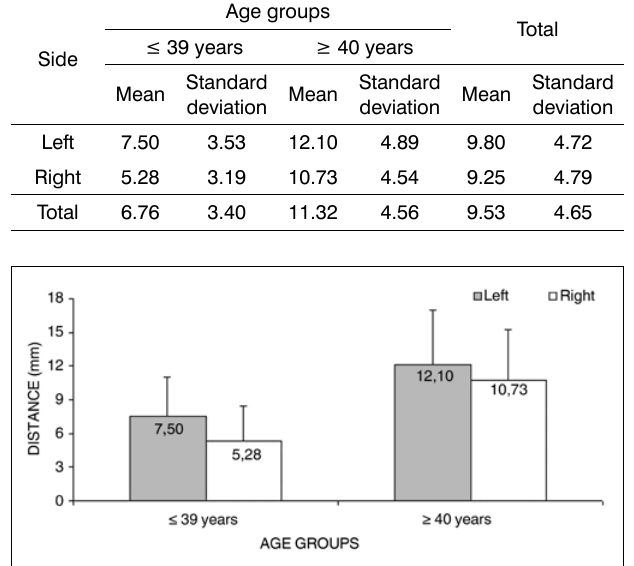
Figure 4. Measurement 3 relative to age and side, in mm (mean ± standard deviation) - measurement 3 (the shortest measurement from the crossing point between the superior thyroid artery and the EBSLN and the most cranial point of the thyroid